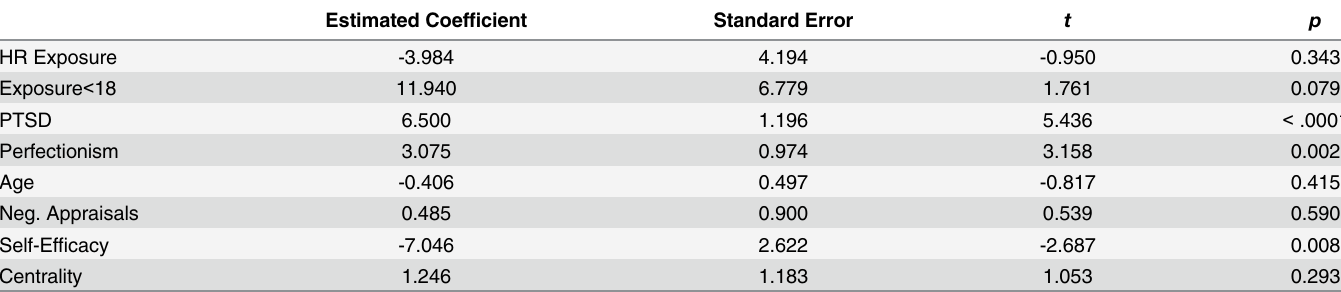
Table 7. Multiple linear regression analysis predicting